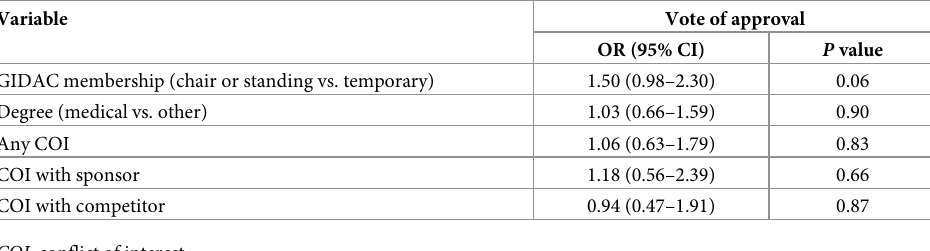
Table 6. Predictors of votes in favour of approval.